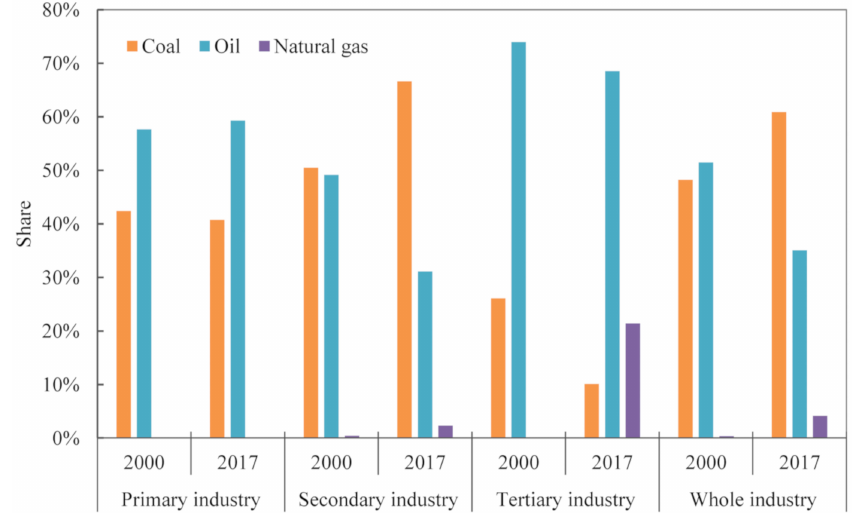
Figure 8. The energy consumption structure of each industry in 2000 and